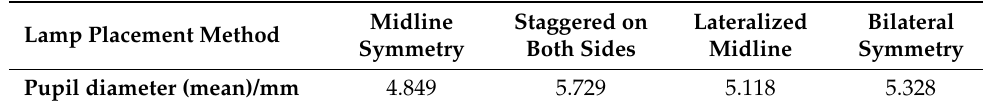
Table 8. Table of influence degree of lamp arrangement and pupil diameter.